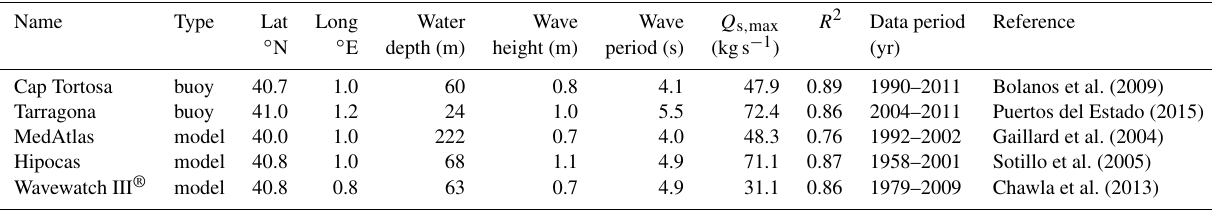
Table 2. Overview of five different sources of wave climate data close to the Ebro Delta. See Fig. 3 for an overview of locations and the angular distribution of alongshore sediment transport potential. Wave height is the effective, yearly averaged wave height weighted by its ability to move sediment alongshore, i.e. ( (cid:54) H 2 . 4 s ) 1 / 2 . 4 . The R 2 value is the coefficient of determination of the alongshore sediment transport calculated from the wave data versus the measurements of Jiménez and Sánchez-Arcilla